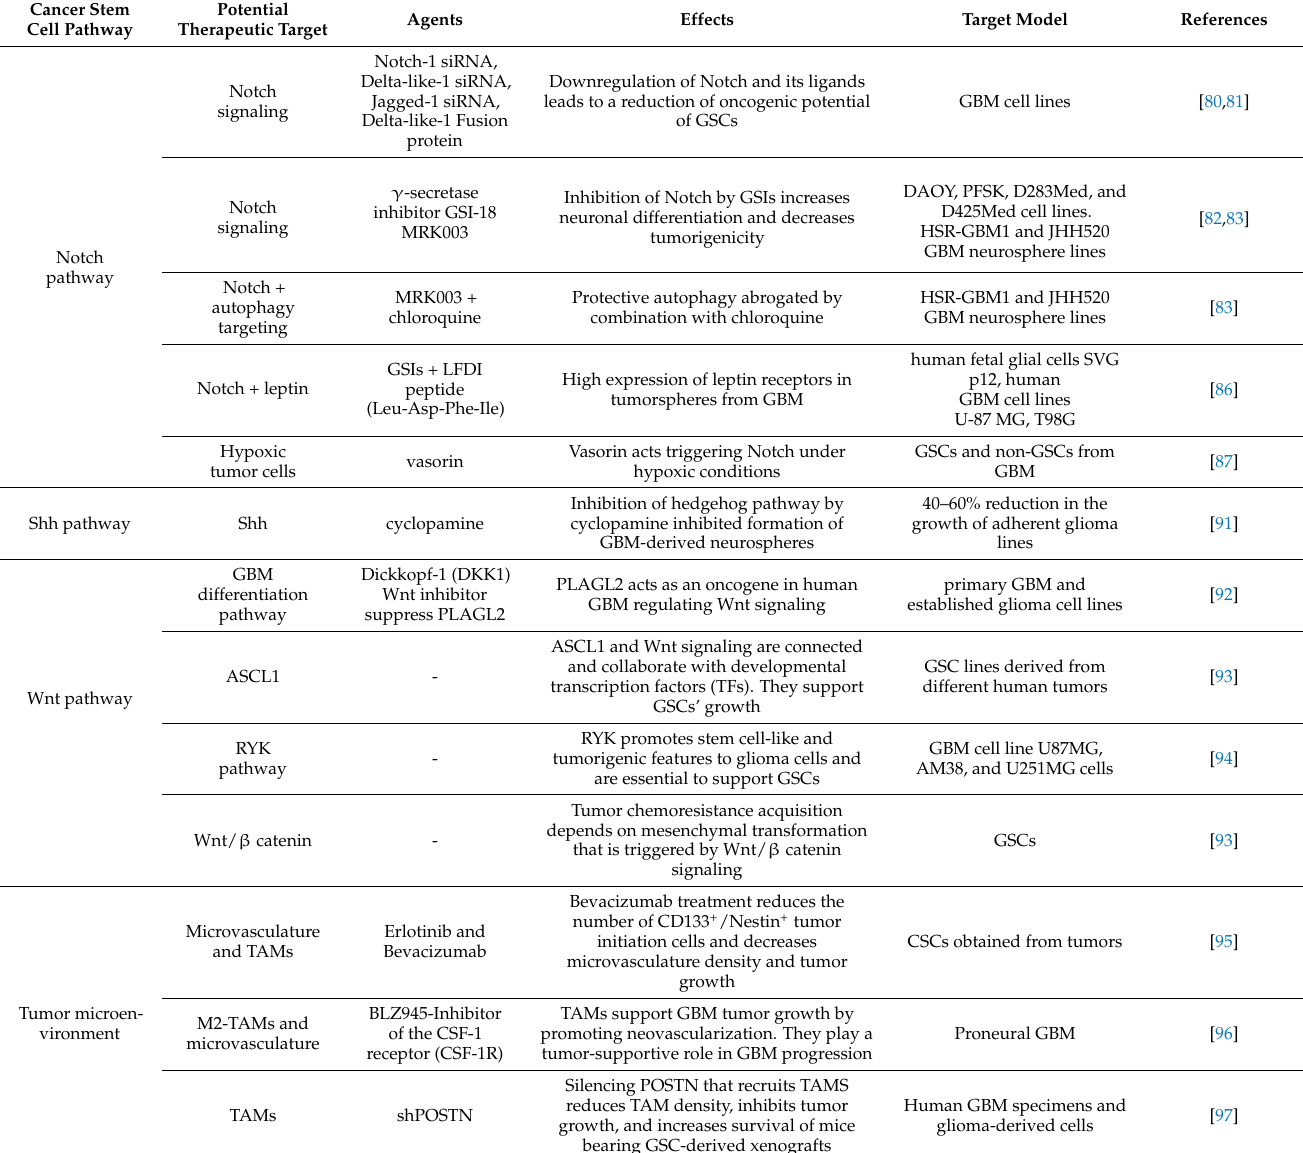
Table 1. Potential therapeutic targets against cancer stem